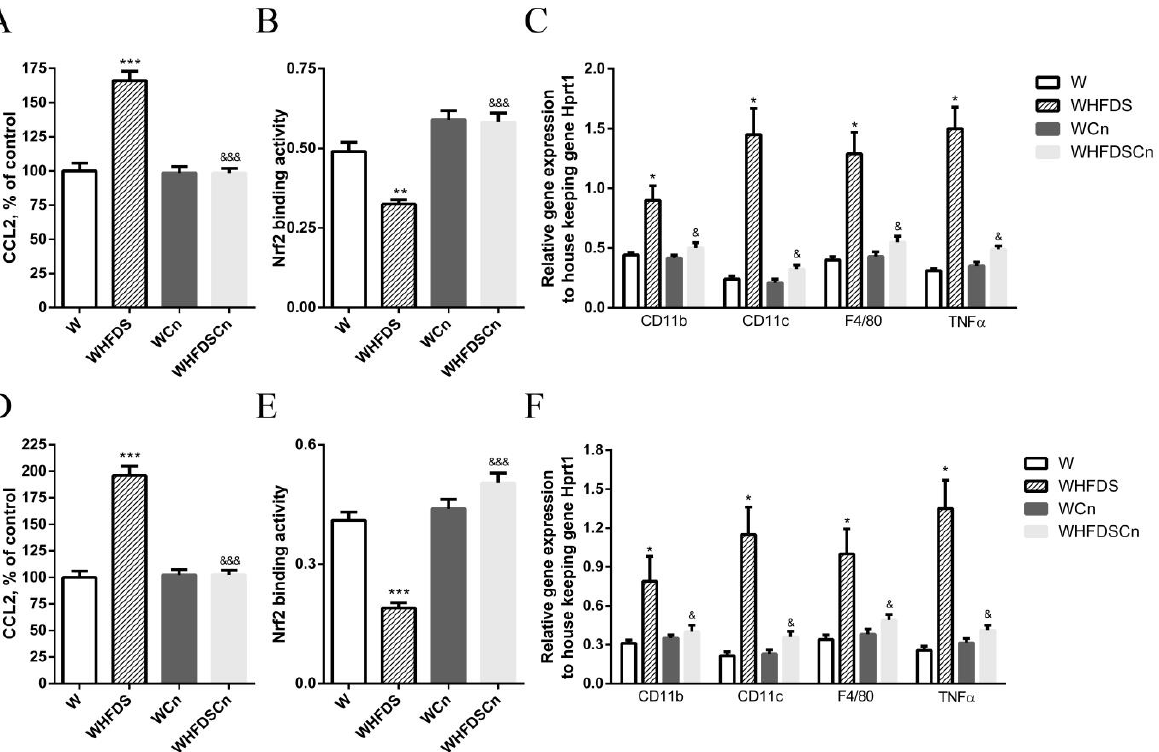
Figure 5. Effects of cinnamaldehyde (Cn) treatment on inflammatory markers and Nrf2 activity in the aortas ( A – C ) and mesenteric arteries ( D – F ) of Wistar (W) rats fed sucrose and high-fat diet (WHFDS), compared to normal W rats. Chemokine (C-C motif) ligand 2 (CCL2) levels ( A , D ), Nrf2 activity ( B , E ) and mRNA expression levels ( C , F ) of indicated genes in PVAT ( E , F ) of thoracic aortas and mesenteric arteries of WHFDS rats compared with normal W rats. Data are expressed as mean ± SE (n = 12 animals per group). * p < 0.05, ** p < 0.01, *** p < 0.001 vs. W rats; & p < 0.05, &&& p < 0.001 vs. WHFDS